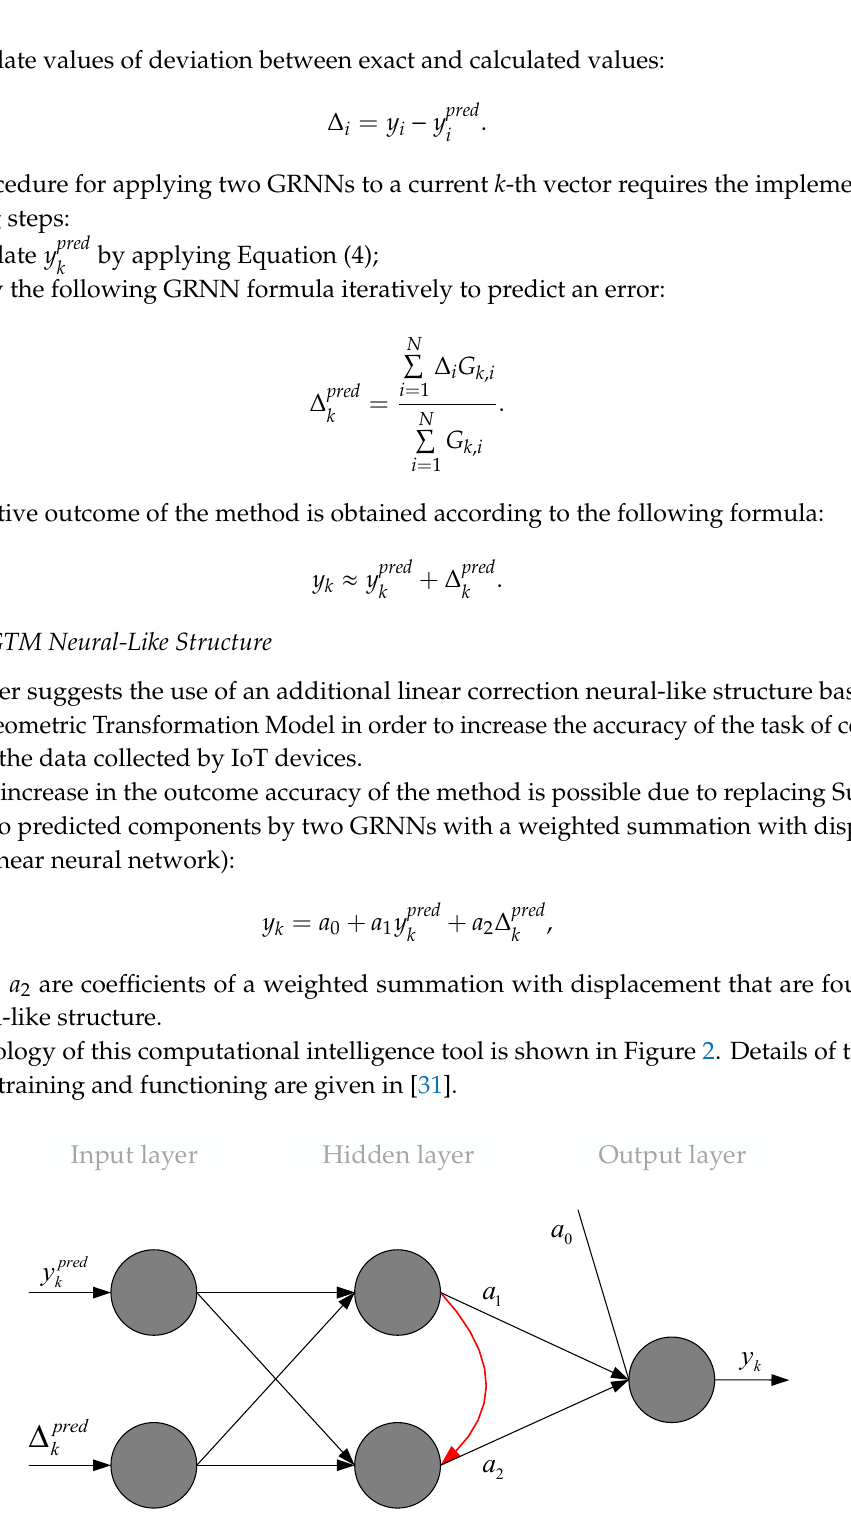
Figure 2. Topology of additional correction linear neural-like structure of the Successive Geometric Transformation Model (SGTM).